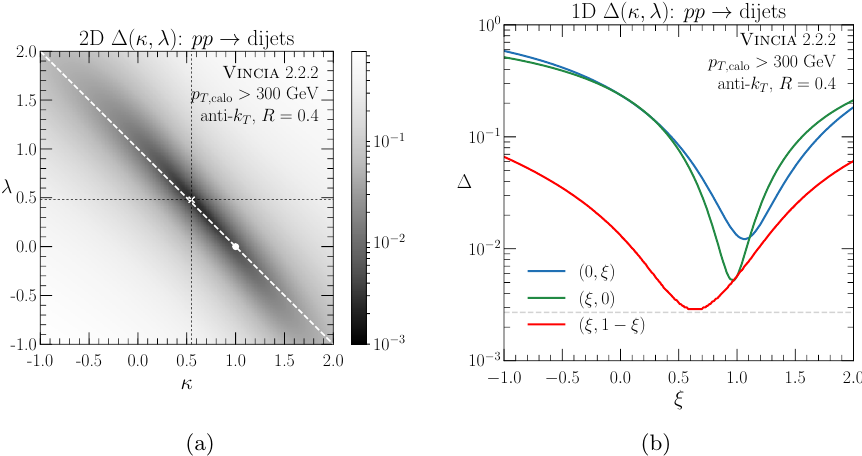
Figure 5 . (a) The (cid:1) statistic in the two-dimensional ( (cid:20); (cid:21) ) space, for the p T; calo > 300 GeV sample. The minimum of (cid:1) occurs at (cid:20) = 0 : 55, (cid:21) = 0 : 48. (b) One-dimensional slices of (cid:1)( (cid:20); (cid:21) ), corresponding to (cid:12)gures 2(b), 3(b), and 4(b), parametrized by a common variable (cid:24) . The horizontal dashed line indicates the global minimum value of (cid:1)( (cid:20); (cid:21) ).